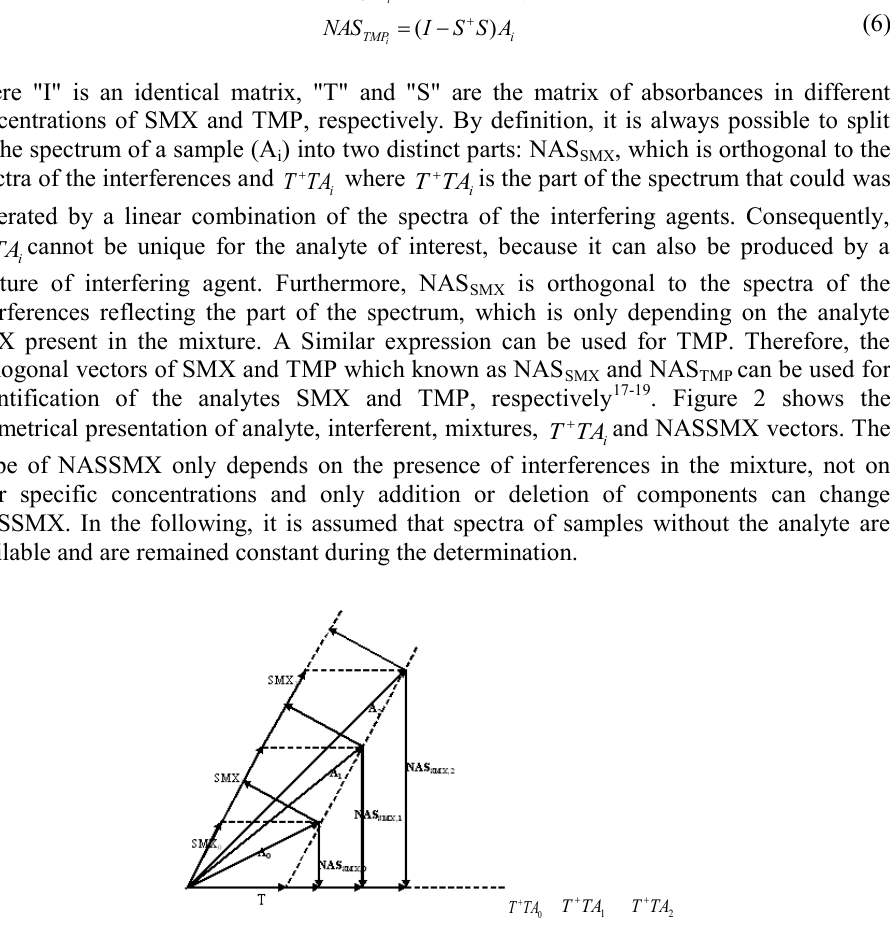
Figure 2. Representation in two dimensional vector space analyte (SMX) and vector